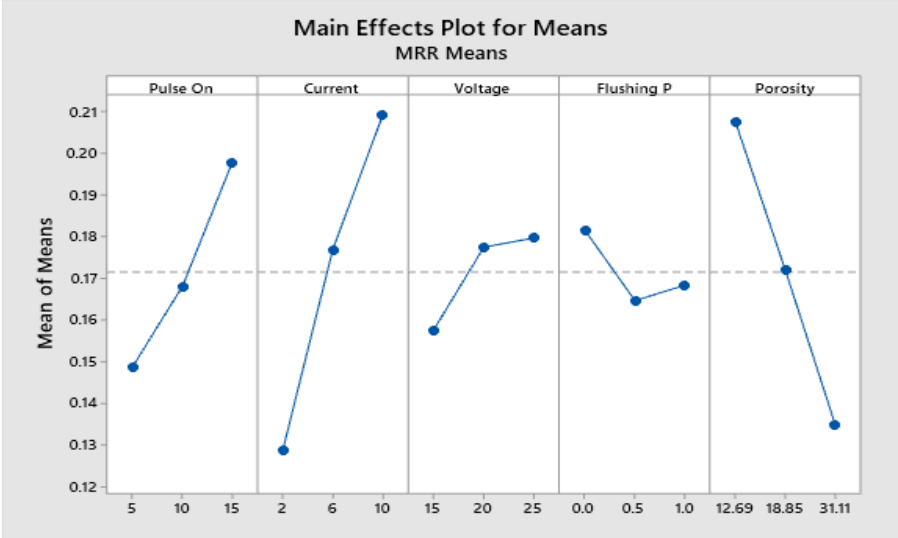
Figure 4. Main effect plot of factors for MRR